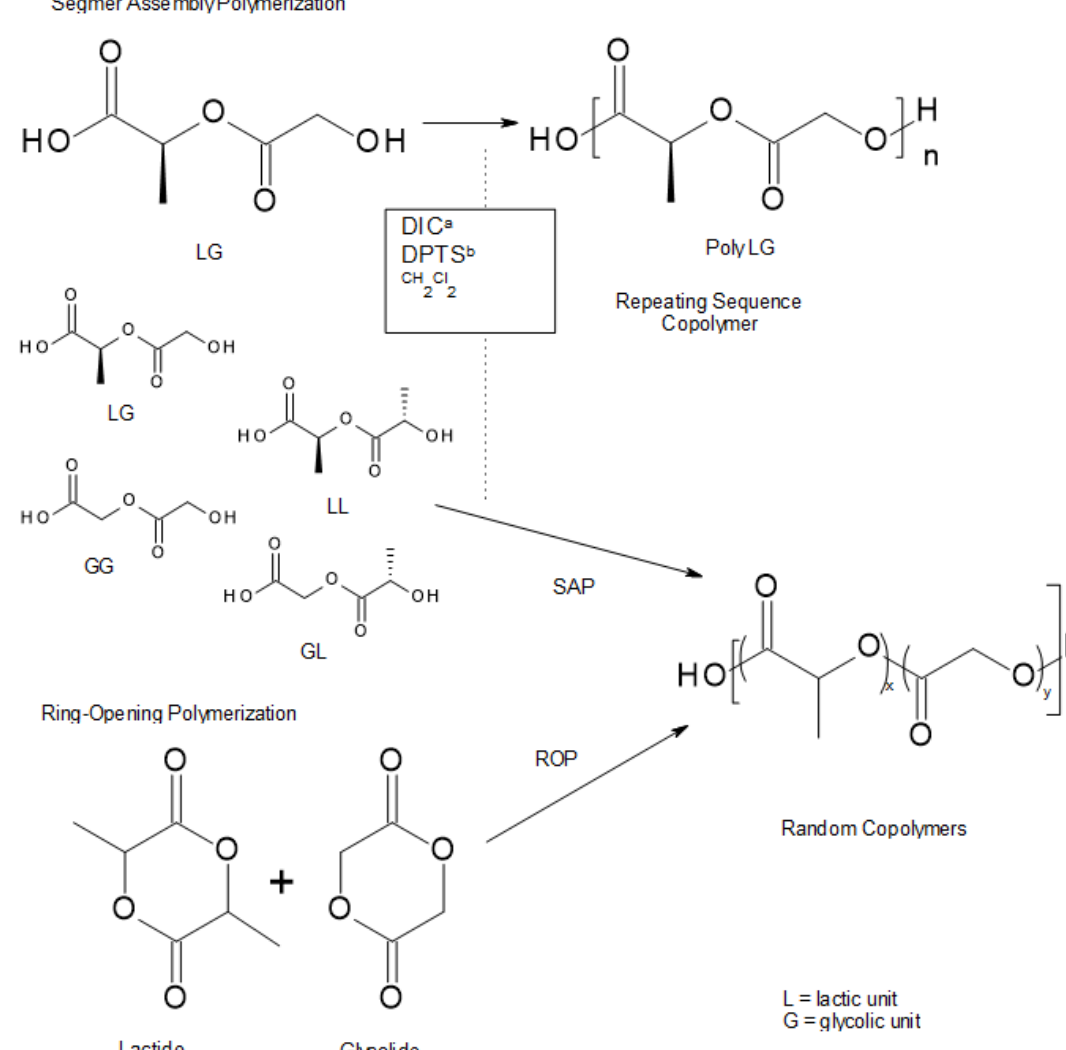
Figure 16. Approaches to sequenced and random PLGAs: (a) DIC = diisopropylcarbodiimide; (b) DPTS = 4-(dimethylamino)pyridinium ptoluenesulfonate. LG, LL, GG and GL are the different dimer units [58].